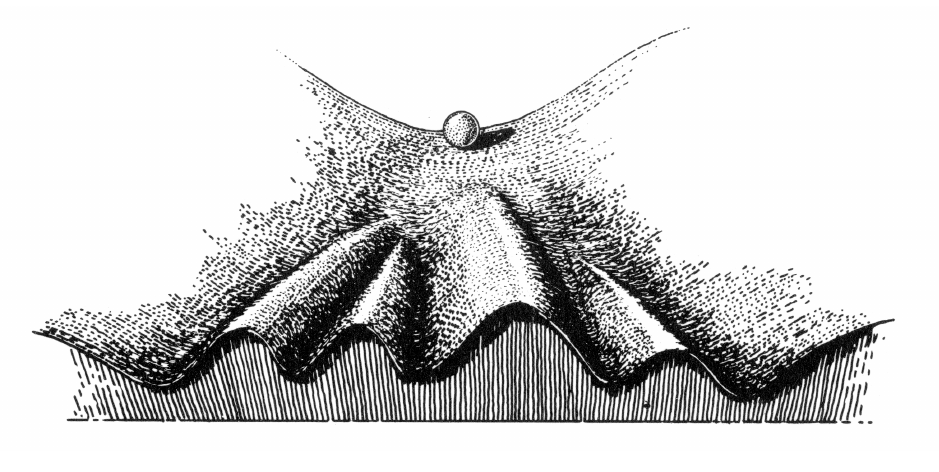
The Epigenetic Landscape, from Conrad Hal Waddington , Principles of Development and Differentiation (New York: Macmillan, 1966), 49 (photo: